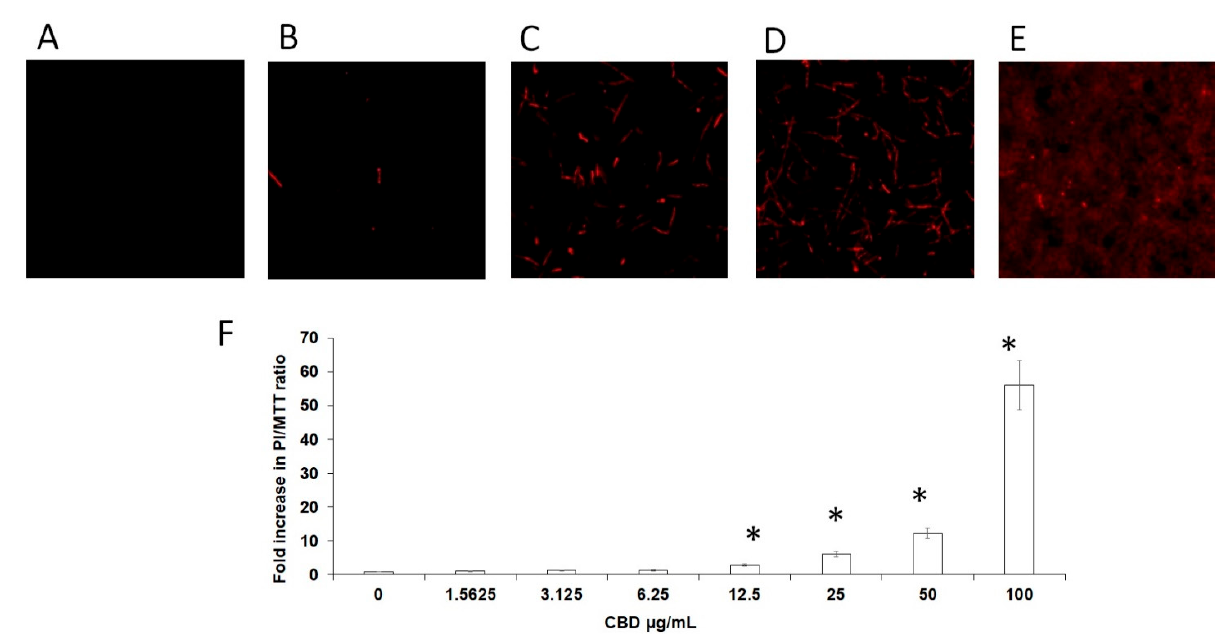
Figure 6. Membrane permeability of biofilm cells. C. albicans biofilms formed after a 24 h incubation with CBD were incubated with PI. A–E. PI-stained biofilms were observed by CLSM. PI staining of untreated control ( A ); biofilms treated with 3.12 μ g/mL ( B ), 12.5 μ g/mL ( C ), 50 μ g/mL ( D ), or 100 μ g/mL ( E ) CBD. Magnification 100×. ( F ). Relative PI fluorescence was measured in a plate reader. The ratios between dead cells and metabolically active cells in biofilms was calculated as PI fluorescence values divided on values obtained from MTT assay (PI/MTT ratio). Data are presented as a fold increase in PI/MTT ratio in treated biofilms compared to PI/MTT ratio in untreated biofilms. * Significantly lower than the untreated control ( p < 0.05).